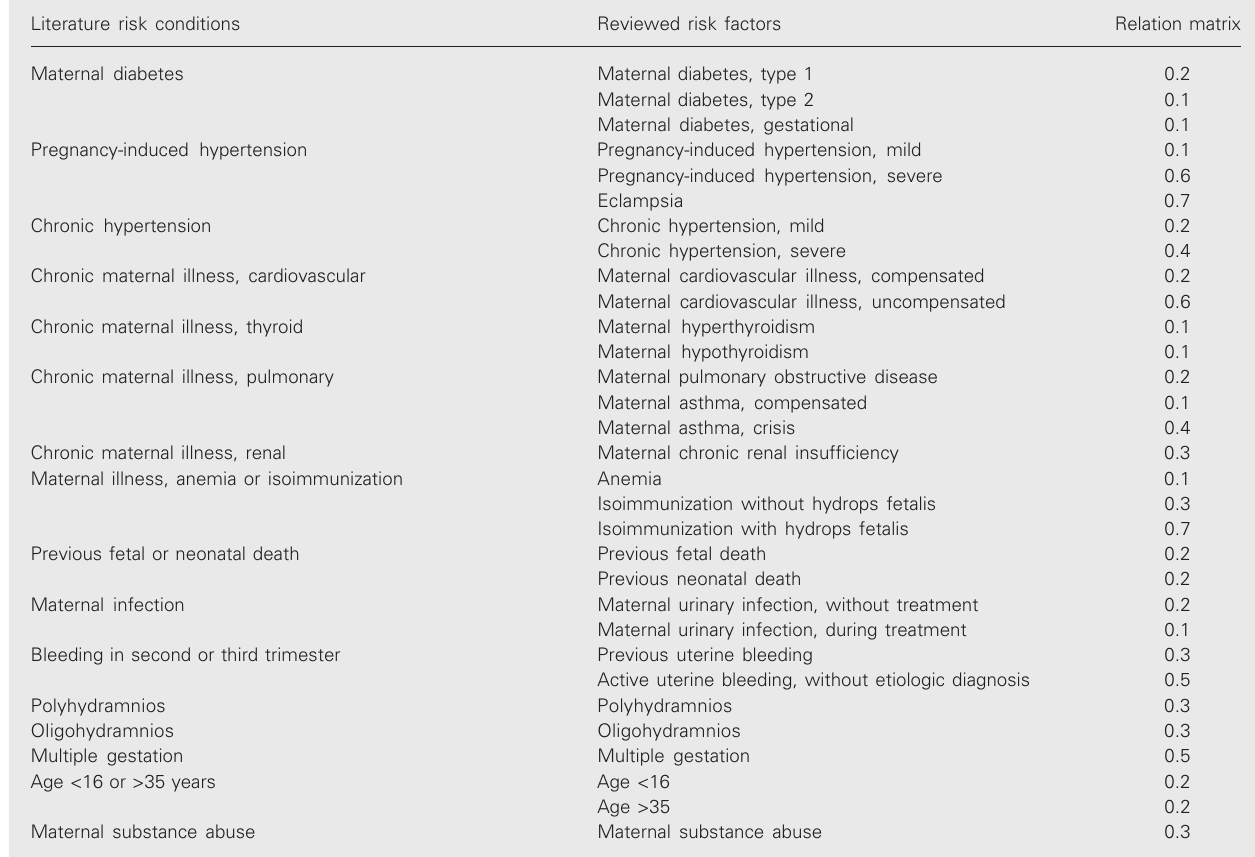
Table 2. Analysis of maternal early gestational risk situations. Literature risk